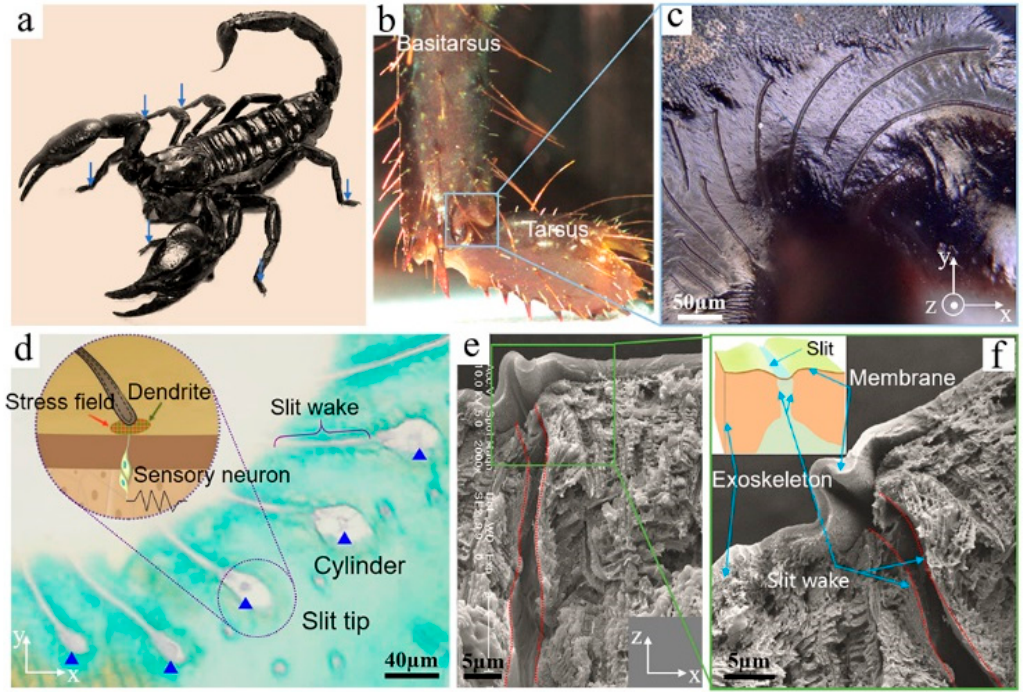
Figure 1. ( a ) The adult scorpion H. petersii collected from Hainan Province, China; ( b ) the distribution of the BCSS on eight walking legs; ( c ) the morphology of Basitarsal Compound Slit Sensilla (BCSS) with slits arranged in fan shape; ( d ) transversal cross-section with toluidine blue staining; ( e ) longitudinal cross-section image; ( f ) local enlarged image taken from ( e ).